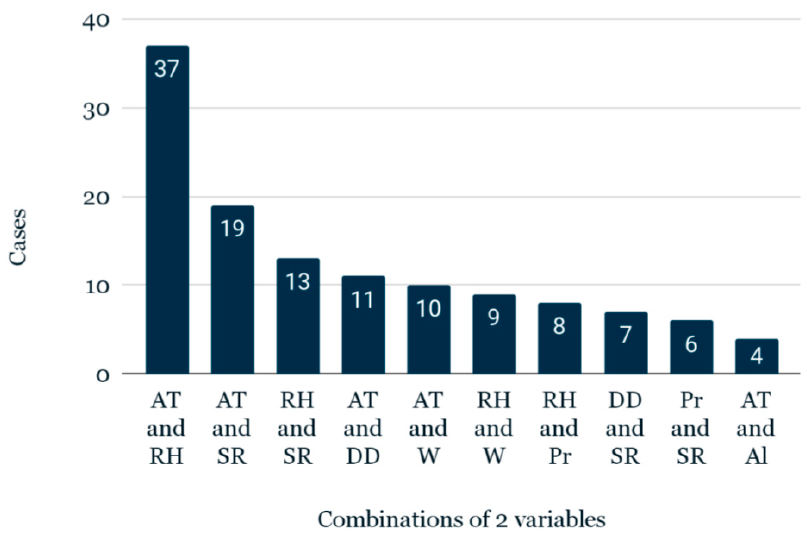
Figure 6. The most popular combinations of two climate variables used for CZB.